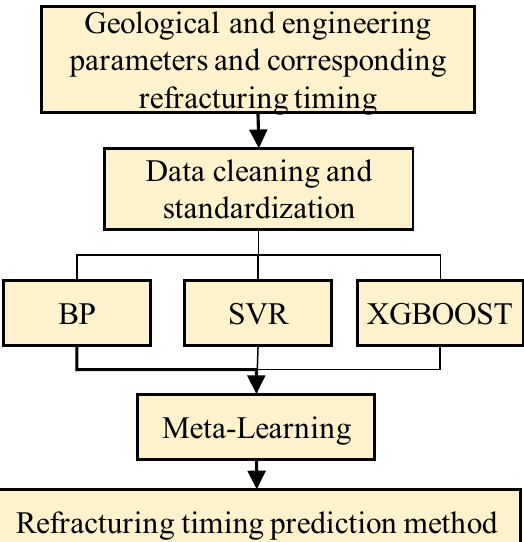
Figure 7. Predictive simulation workflow for repeated fracturing timing.